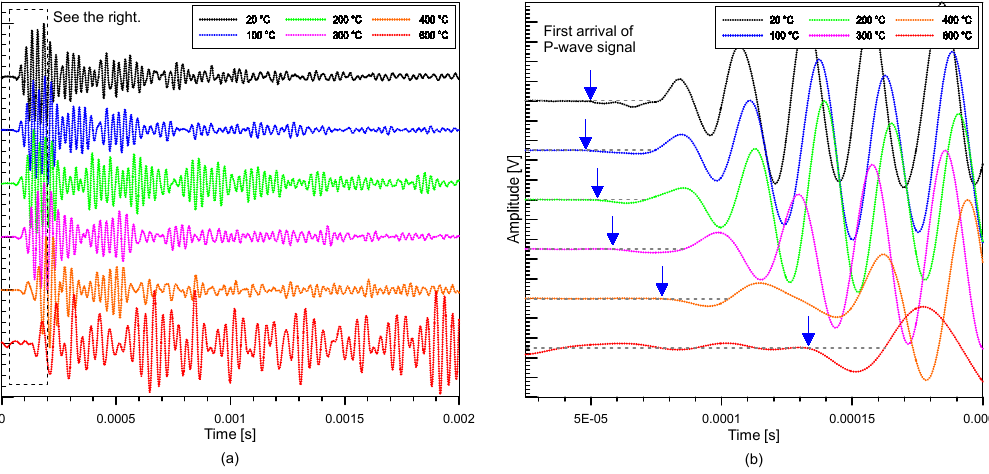
Figure 4. Typical time signals of ultrasonic pulse waves propagating through the thermally-damaged concrete cylinders under different target temperatures: ( a ) ultrasonic waves at different target temperatures and ( b ) enlarged ultrasonic signal around the first arrival of the wave shown in ( a ).